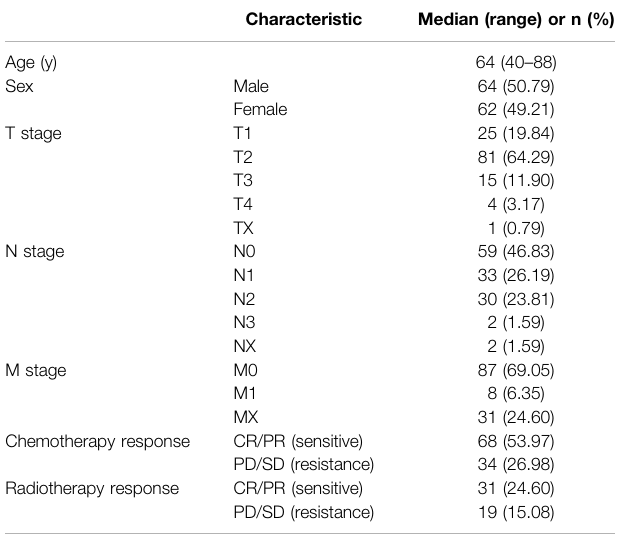
TABLE 1 | Baseline characteristics of patients (N (cid:1)